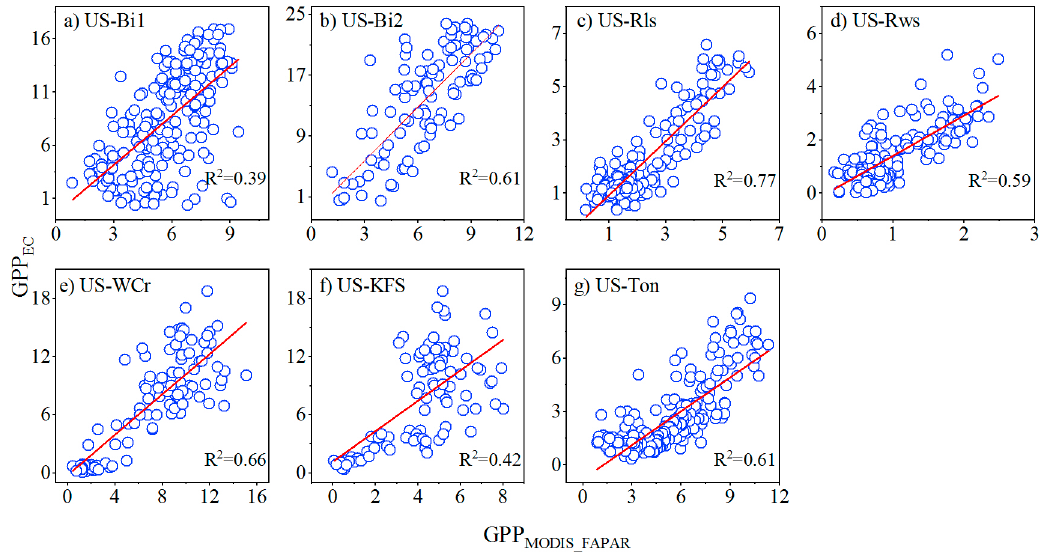
Figure 9. Temporal dynamics of GPP MODIS-FAPAR (GPP with the FAPARfrom the Moderate Resolution Imaging Spectroradiometer (MODIS)), GPP OLCI-FAPAR , and GPP EC for all sites in 2017 and 2018. ( a – g ) represent the sites the same as Figure 2.